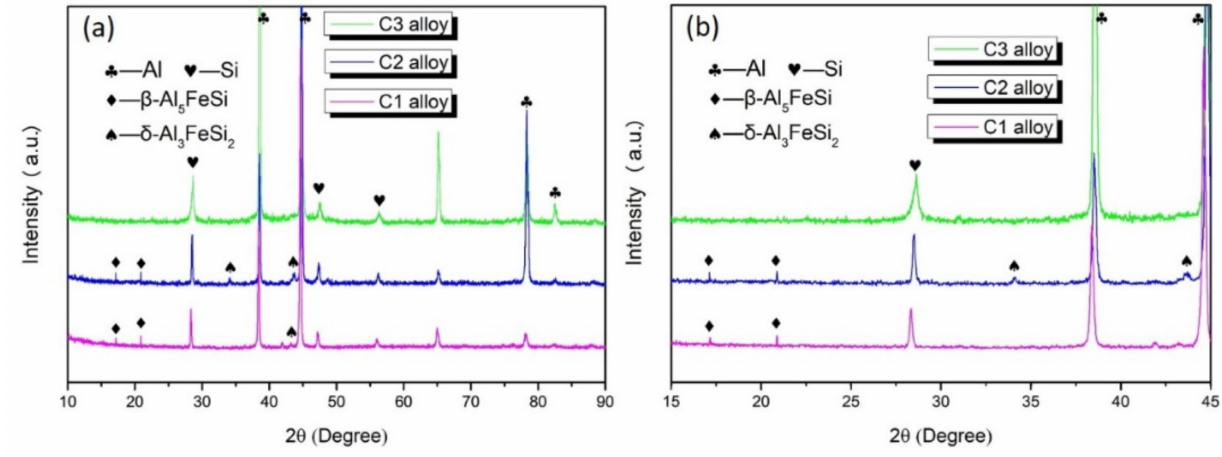
Figure 1. ( a ) XRD spectra of the C1, C2, and C3 alloys. ( b ) Shows the partially amplified spectra of ( a